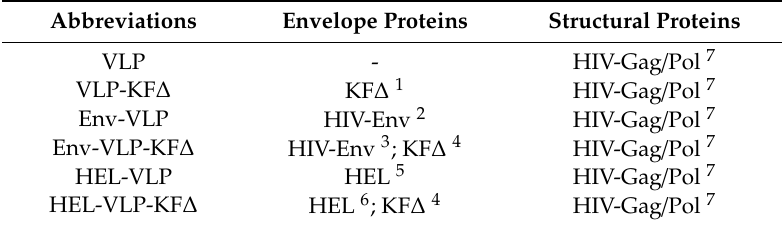
Table 1. HIV-based virus-like particle preparations used in the